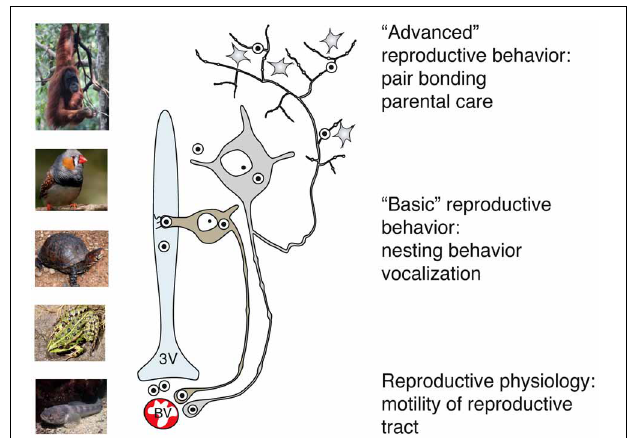
FIGURE 5 | Main pathways of OT release reflect its peripheral and central effects on reproduction in basal and advanced vertebrates. While OT release into systemic blood circulation (via axo-vasal contacts) modulates motility of the reproductive tract, central OT release either into the cerebro-spinal fluid (via dendro-ventricular contacts) or into brain tissue (via axonal release) orchestrates reproductive behavior. Peripheral release of OT into the blood occurs in all vertebrates, however, release into the cerebro-spinal fluid is prevailing in basal vertebrates, which exhibit rather simple, stereotyped forms of OT-dependent reproductive behavior. In contrast, axonal OT release seemed to appear only in advanced vertebrates, especially in mammals. Taking in consideration the parallelism of appearance of OT axons in the forebrain and complex OT-mediated forms of reproductive and pro-social behavior, we speculate about a causative relation between these two processes in high vertebrates. 3v, 3rd ventricle; BV, blood